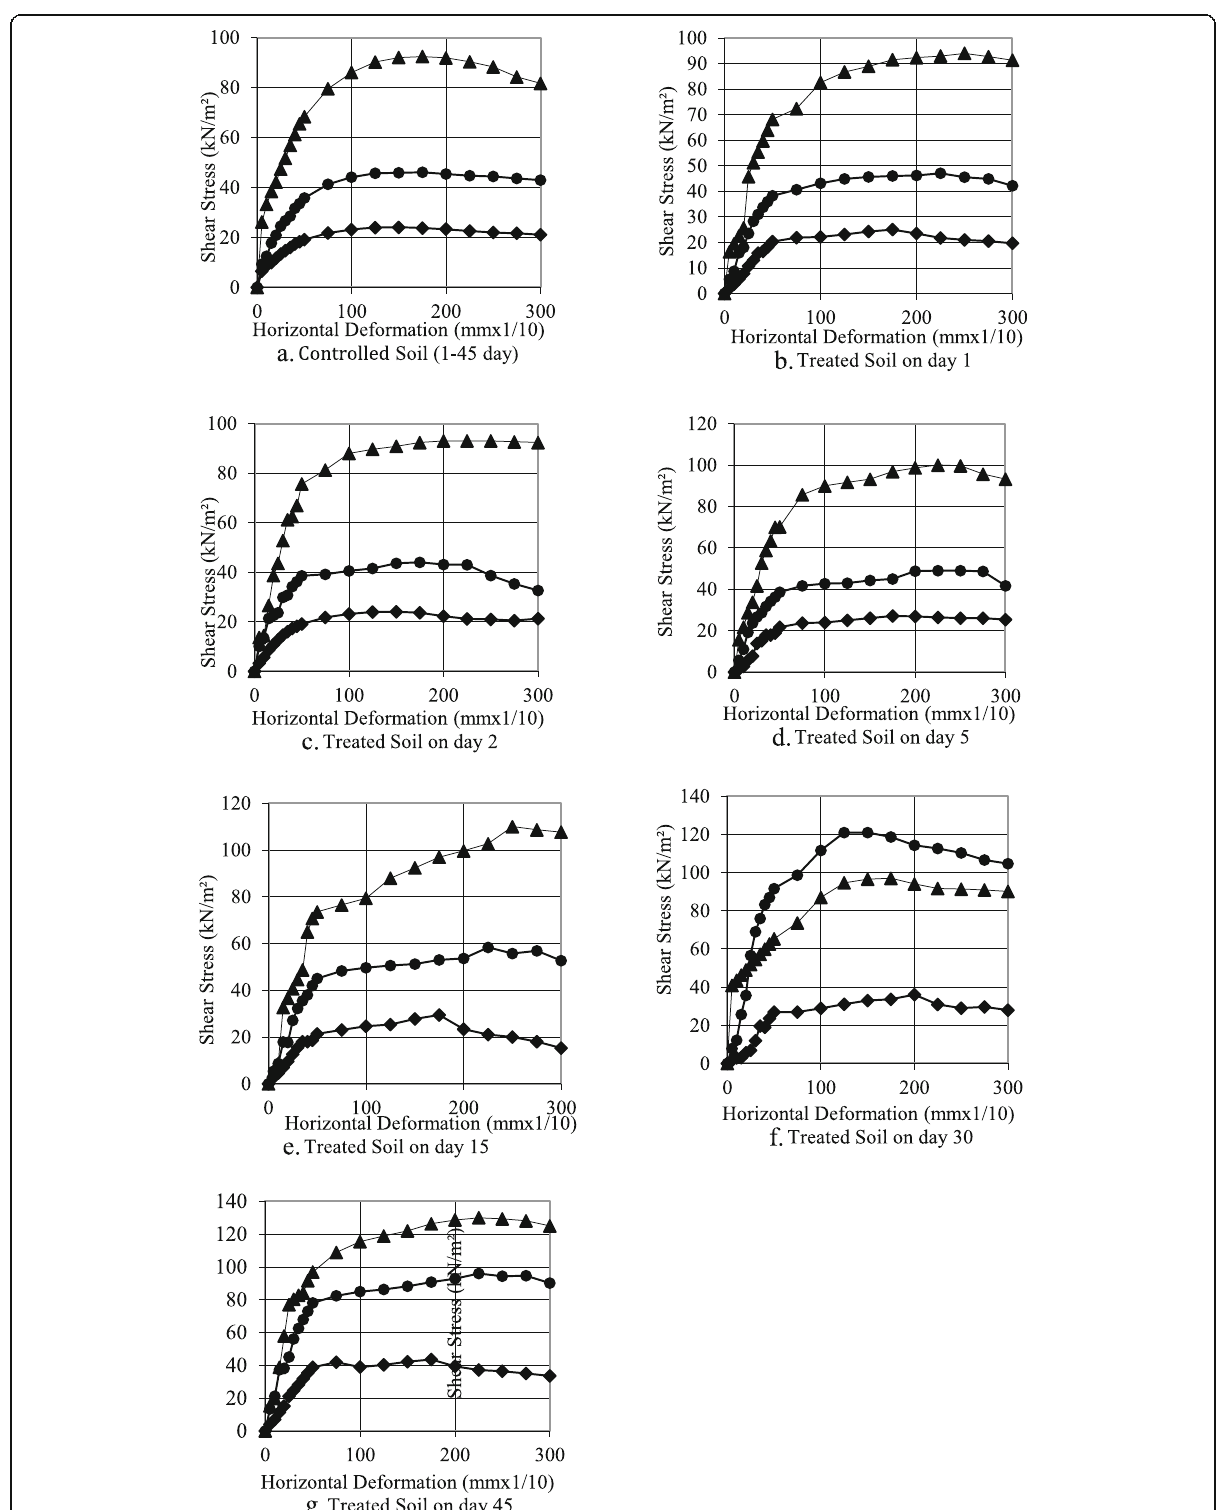
Fig. 1 The shear stress-horizontal deformations of controlled and treated soil